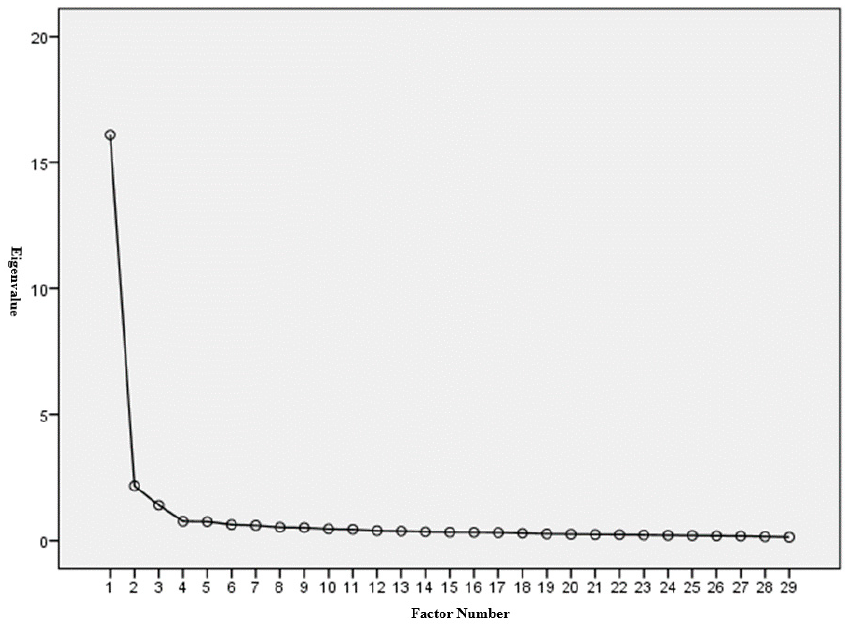
Figure 1. Scree plot for exploratory factor analysis of ECS-IN.